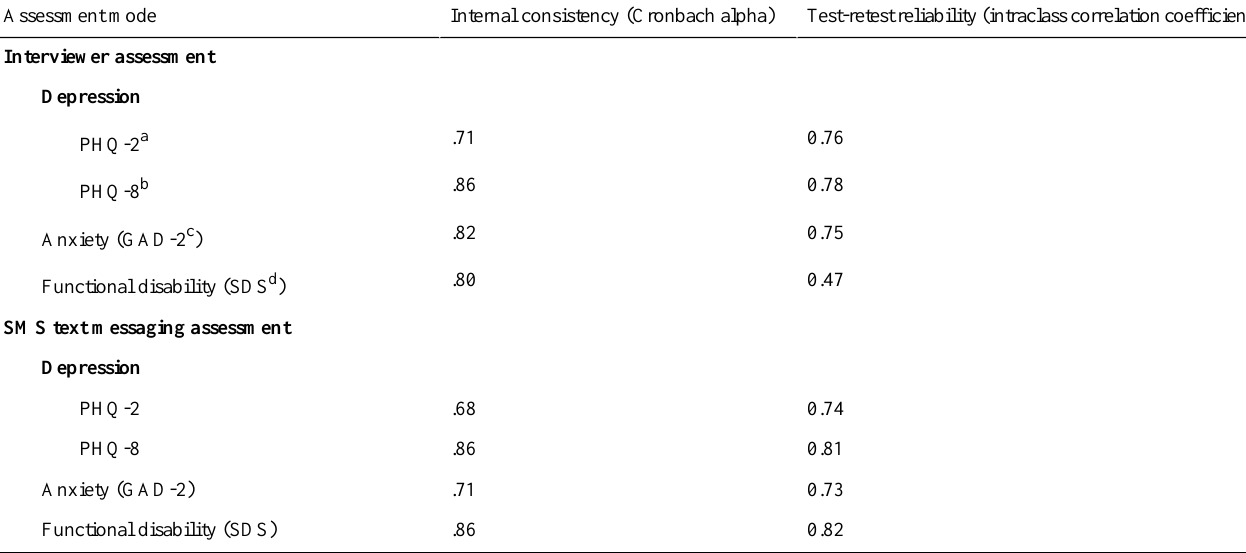
Table 2. Internal consistency and test-retest reliability of the interviewer and SMS text messaging